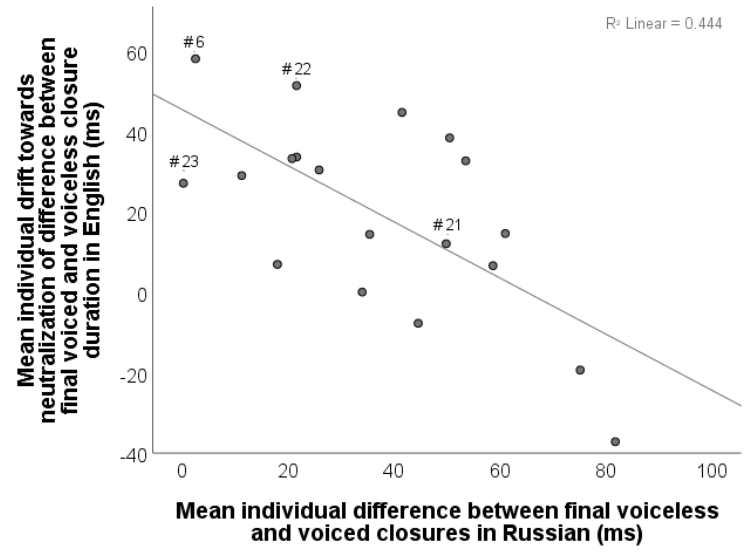
Figure 19. Correlation between average individual L1 drift towards the reduction in voiceless-voiced closure duration di ff erence in final stops / a ff ricates and average individual di ff erence between final voiceless and voiced closures in Russian ( y -axis: larger values indicate greater drift towards Russian-like contrast neutralization; x -axis: larger values indicate greater distinction between voiced and voiceless obstruents). Labelled datapoints are participants who had lived in Russia.